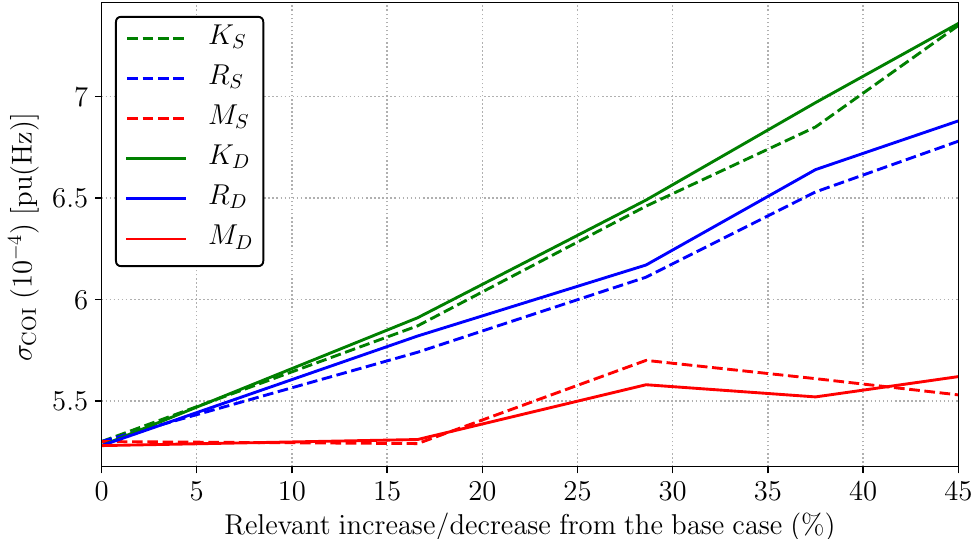
Figure 6. 5-min time period— σ COI as a function of different frequency controllers/machine